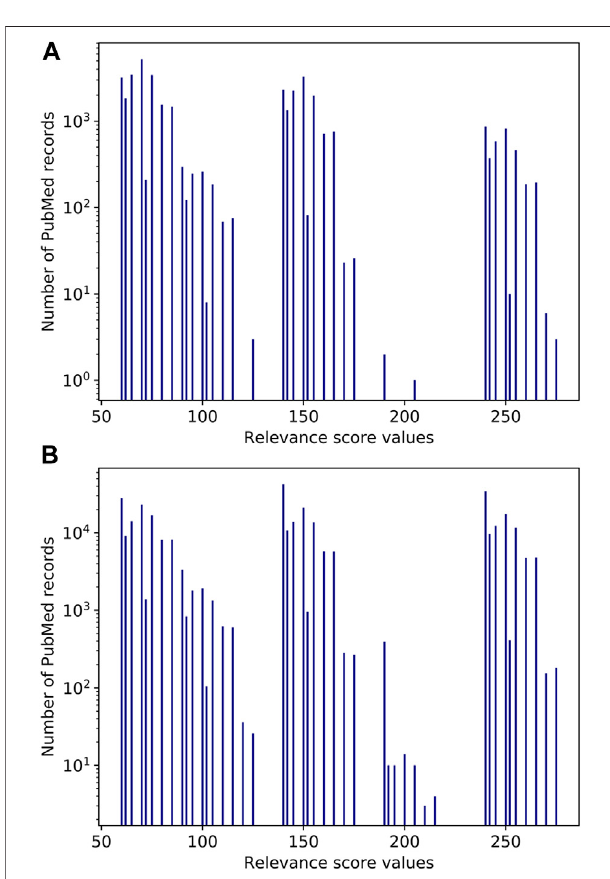
FIGURE 10 | Histograms of the relevance score values for D-glucose (A) in PubMedrecordswhereD-glucoseisco-mentionedwithcholesterol,(B)inPubMed records where D-glucose is co-mentioned with any PubChem compound.